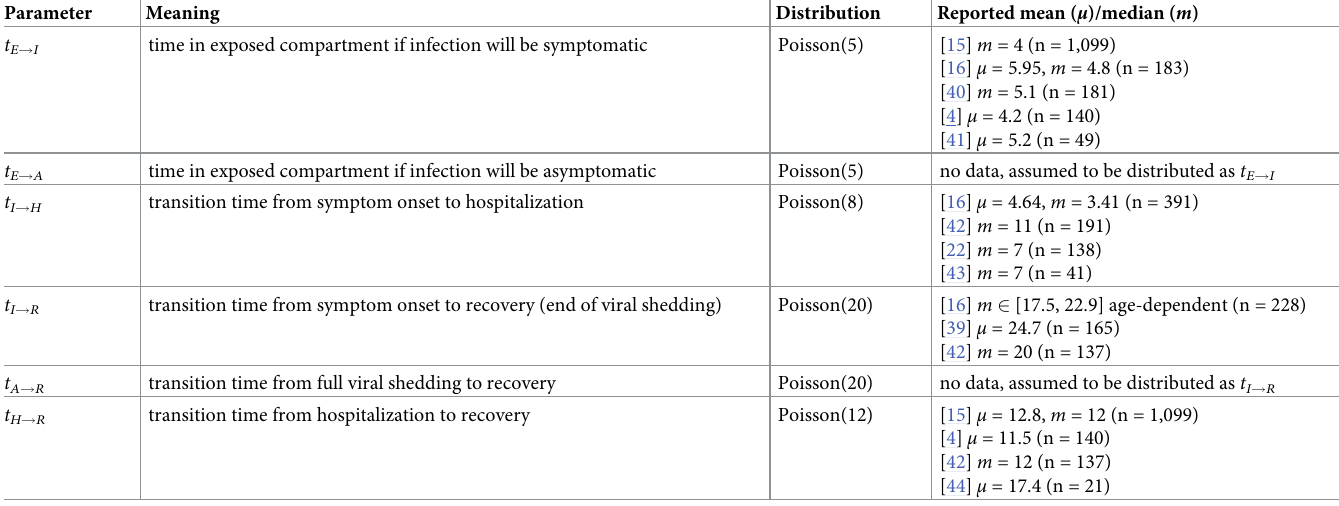
Table 2. Transition distributions. Distributions used to model the time an individual spends in each transient, contagious compartment (all times in days). Mean ( μ ) and median ( m ) estimates and sample sizes ( n ) from the literature are reported where available. Parameter Meaning Distribution Reported mean ( μ )/median ( m